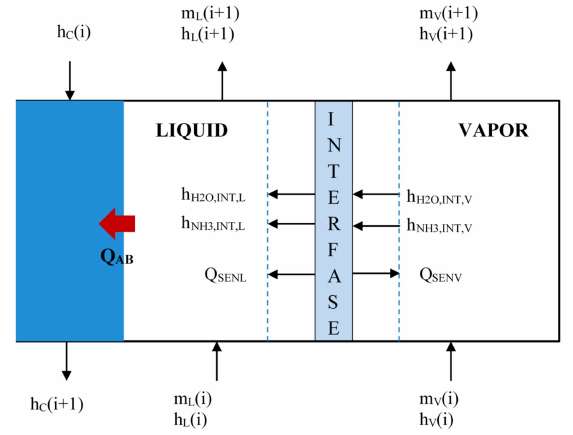
Figure 4. Control volume of bubble